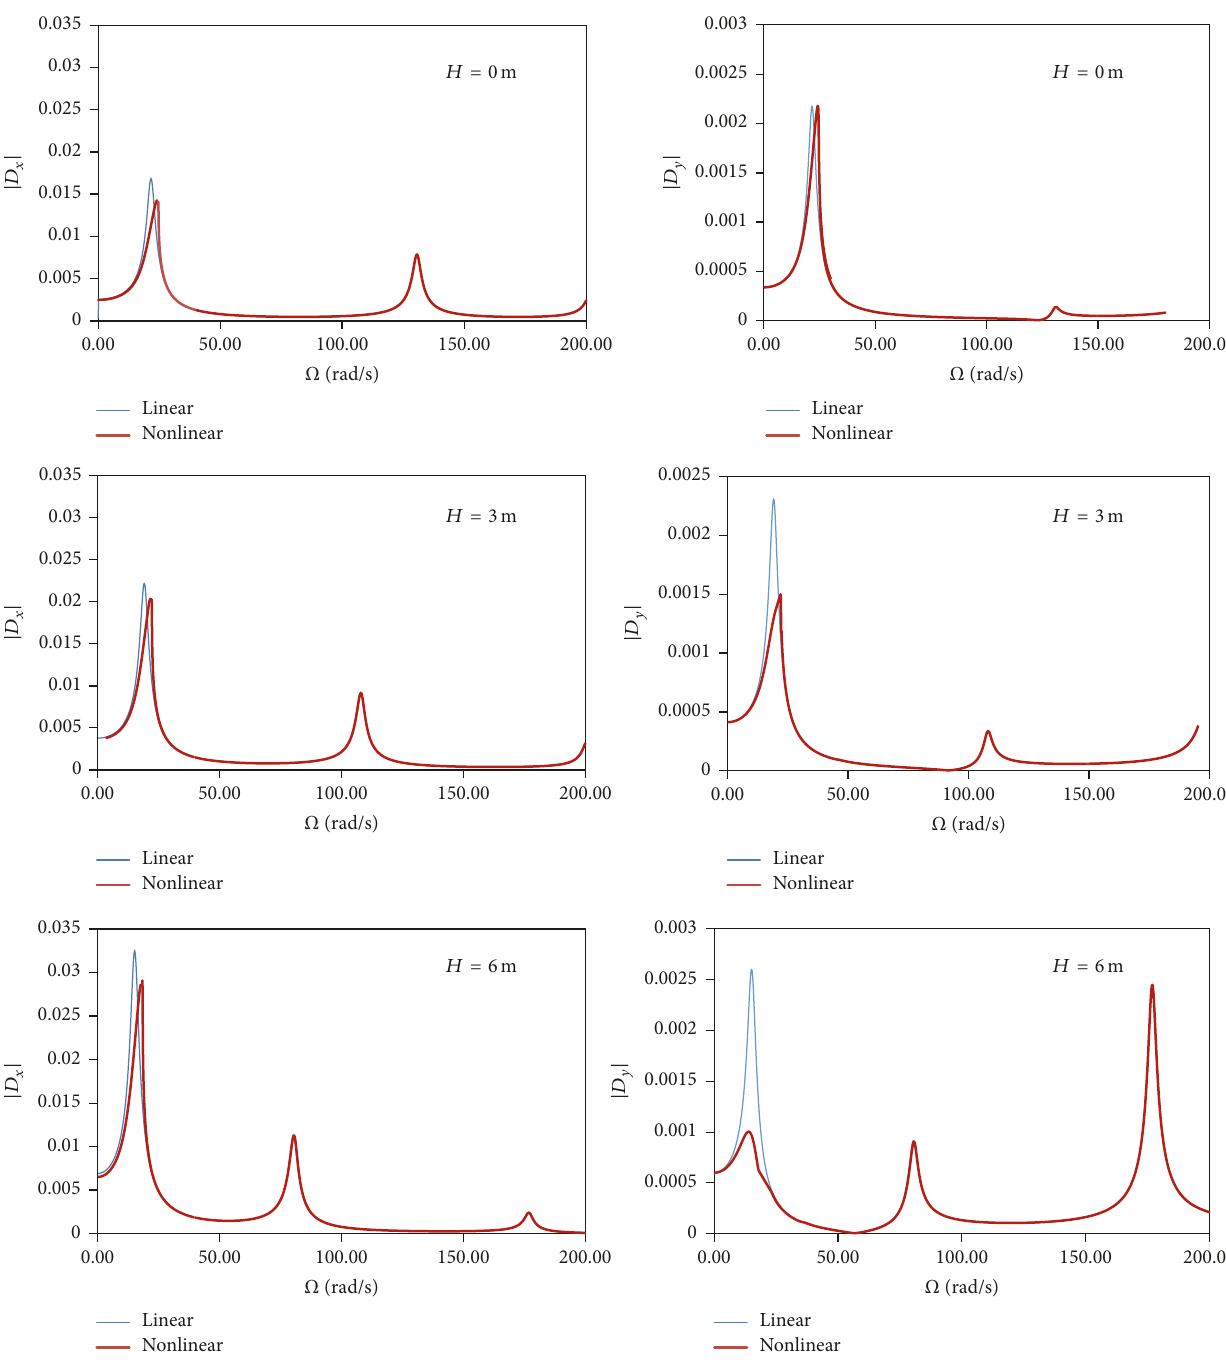
obtained with the present HBM-Galerkin scheme and with time domain simulations are very close, validating the non- linear formulation. It can be also observed that the algorithm is able to bypass the limit point associated with the saddle- node bifurcation. As expected, the time domain analysis is not able to trace the unstable branches of resonance